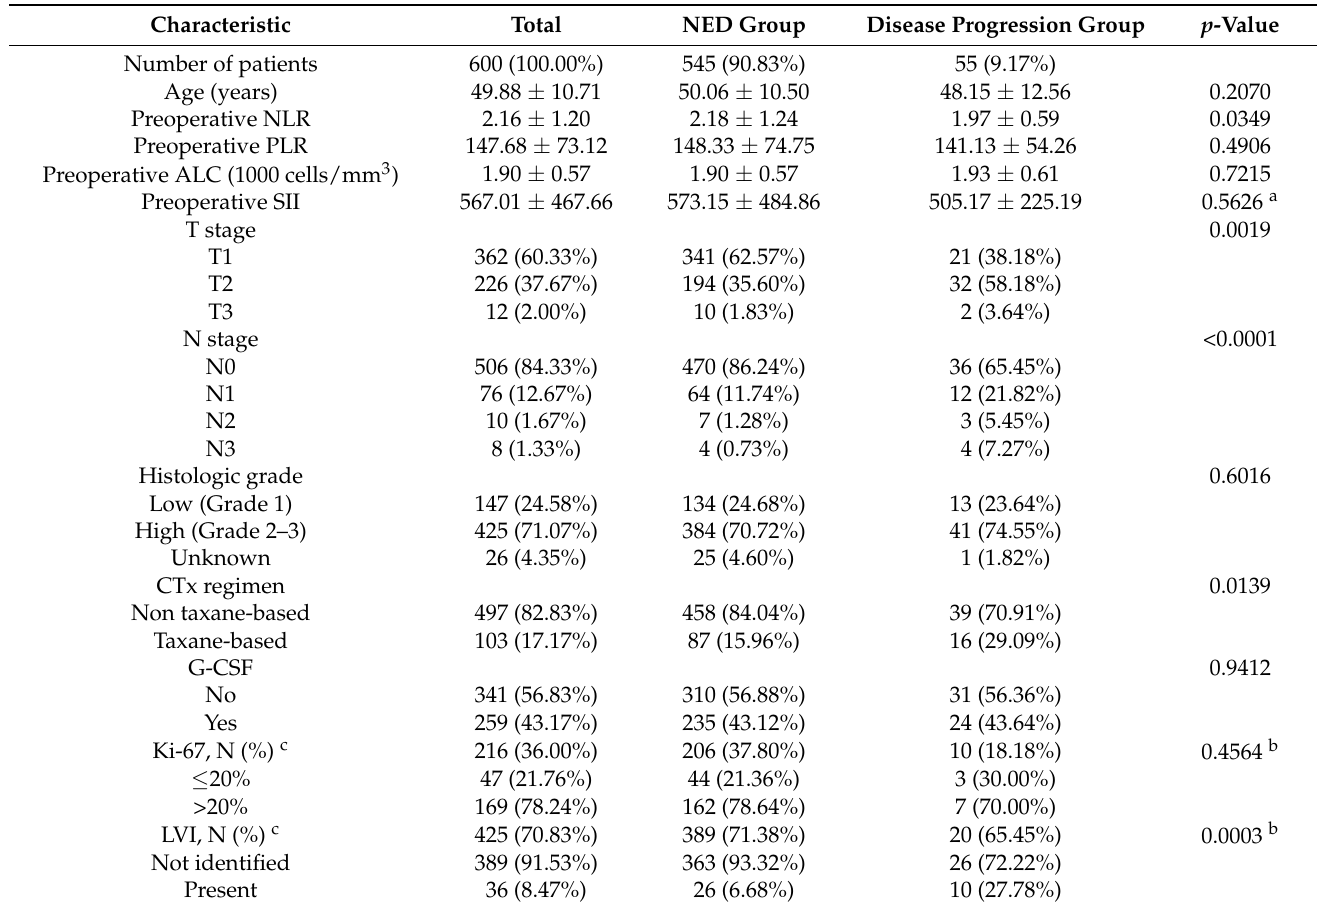
Table 1. Baseline